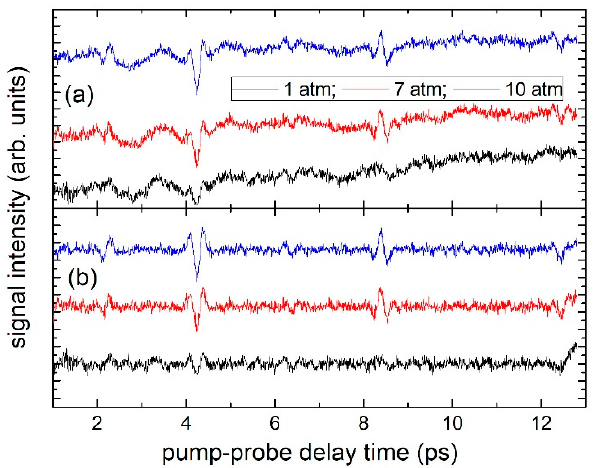
Figure 2. ( a ) Time-dependent ISRS signals measured in N 2 at different pressures. ( b ) Same as ( a ) after FT filtering (see text).